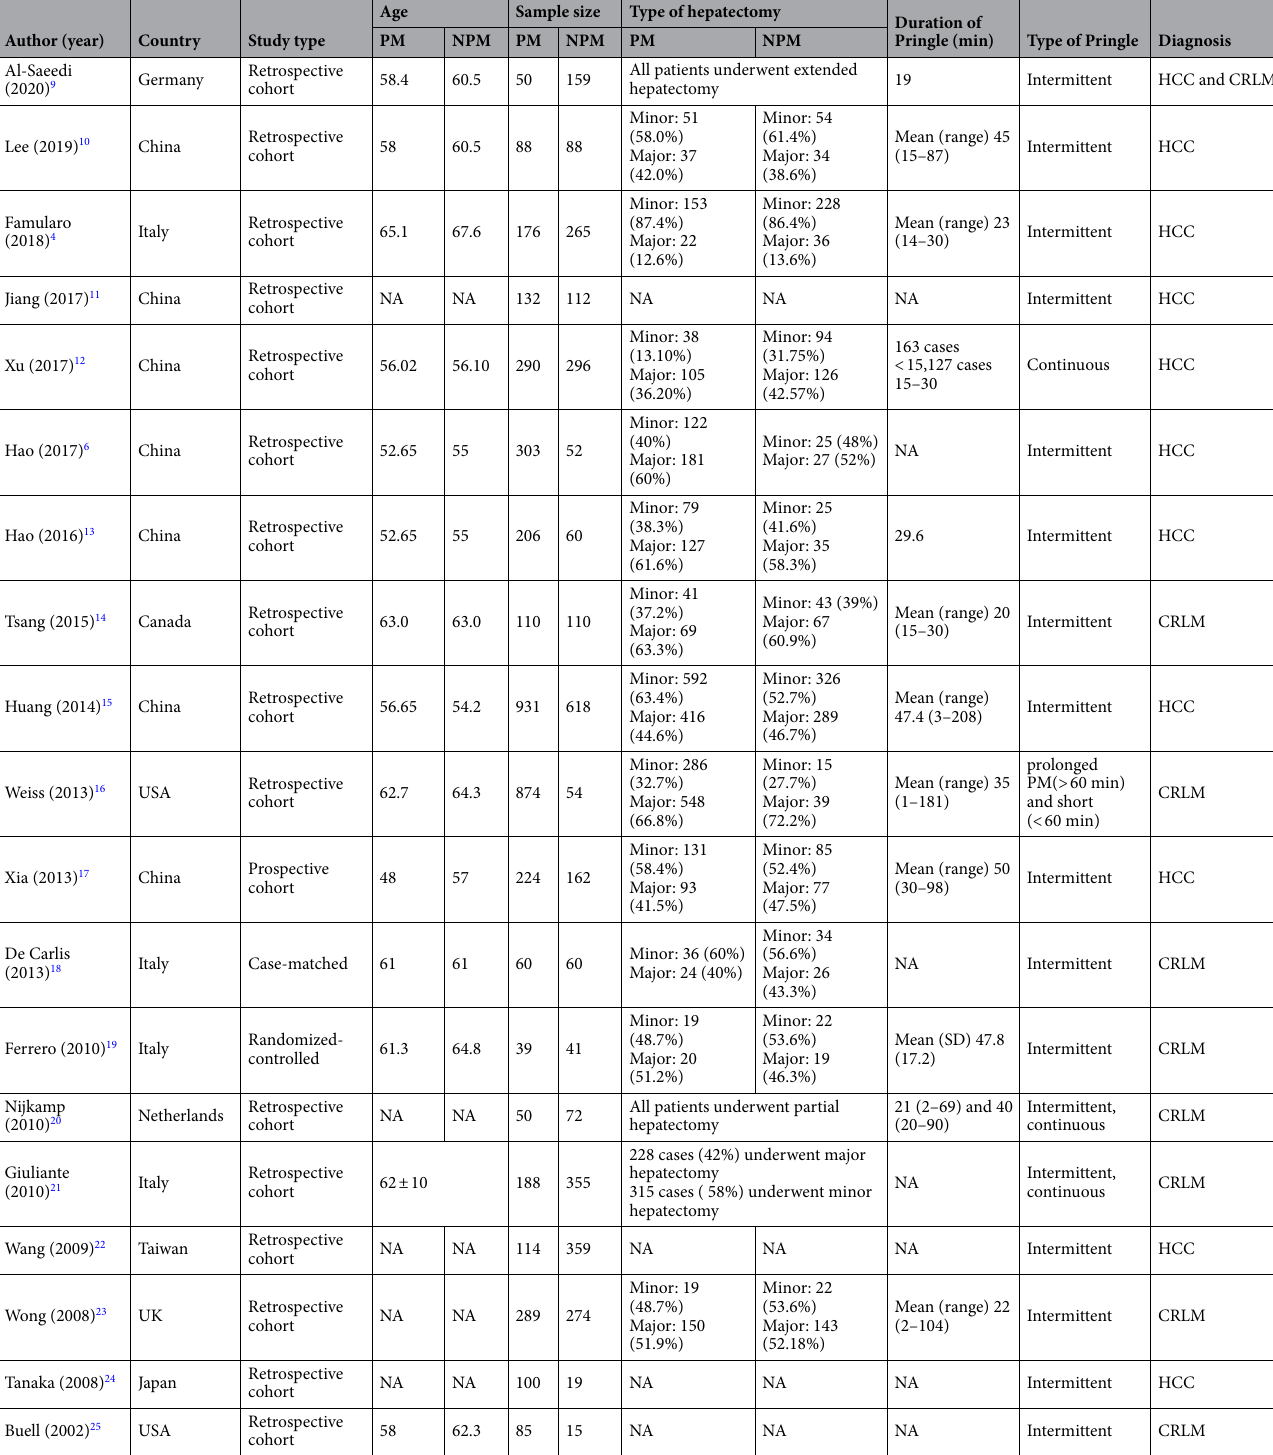
Table 1. Characteristics of included